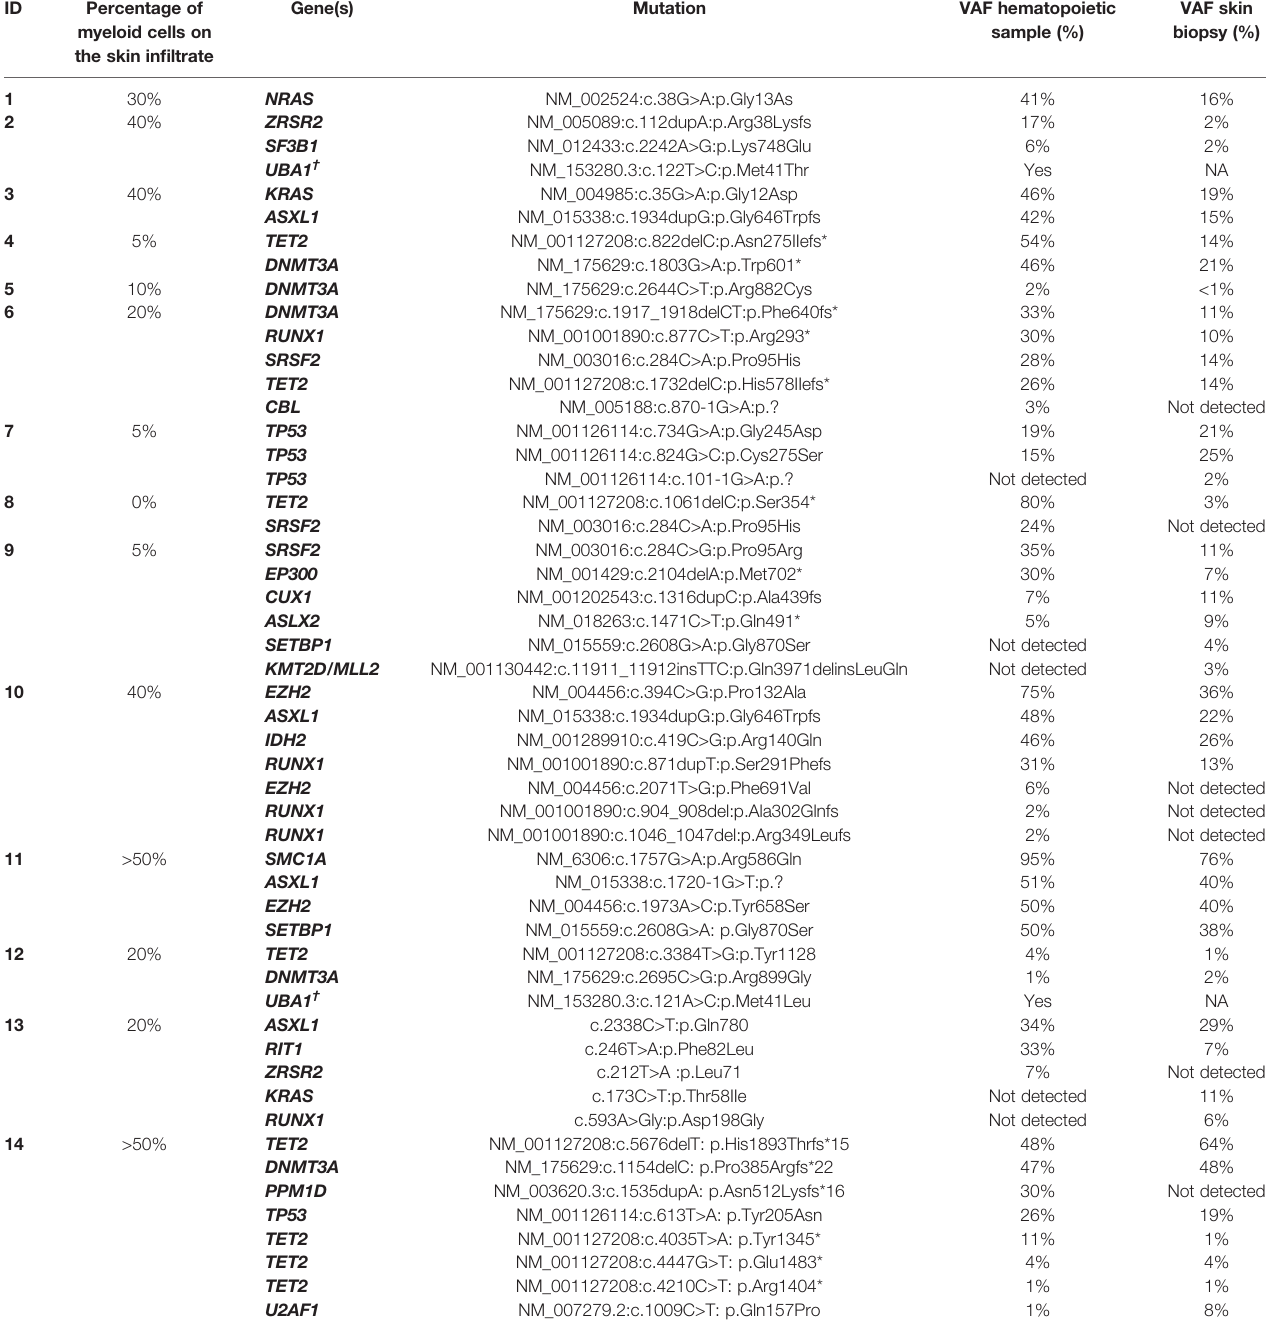
TABLE 3 | Mutations in hematopoietic and skin